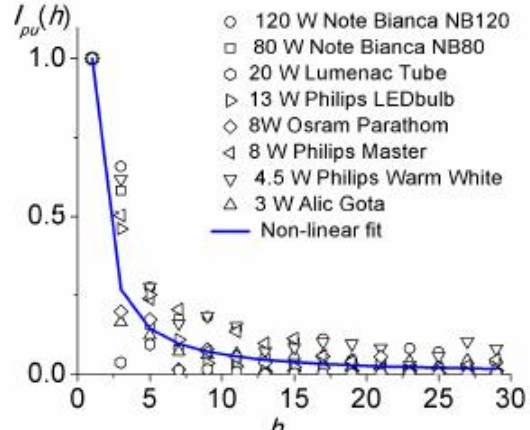
Figure 1: Harmonic currents content of different LED lamps. Taken from